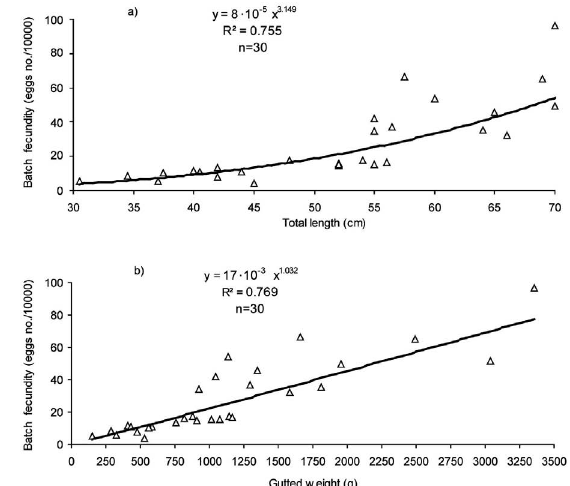
Fig . 7. – Relationships between batch fecundity and a ) total length (cm), and b) female gutted weight